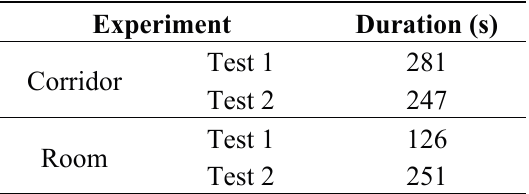
Table 2. Duration of each